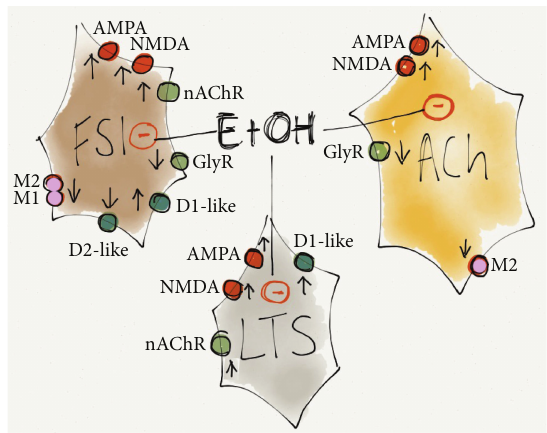
Figure 2: Schematic drawing showing acute effects by ethanol on striatal interneurons. Ethanol exerts a complex modulatory role on striatal interneurons by interacting with multiple receptor systems and signaling pathways, resulting in decreased firing frequency of both GABAergic and cholinergic interneurons, even though FSI activity has been shown to increase in slice recordings performed in the dorsal striatum. Arrows mark the impact on firing frequency caused by activation of the receptor (up/down), while the color marks whether ethanol acts inhibitory (red) or possibly inhibitory (pink) or facilitates (green) receptor activation. In addition, ethanol is presumed to elevate dopamine levels resulting in activation of dopamine receptors (blue), further modulating neuronal activity. See text for further